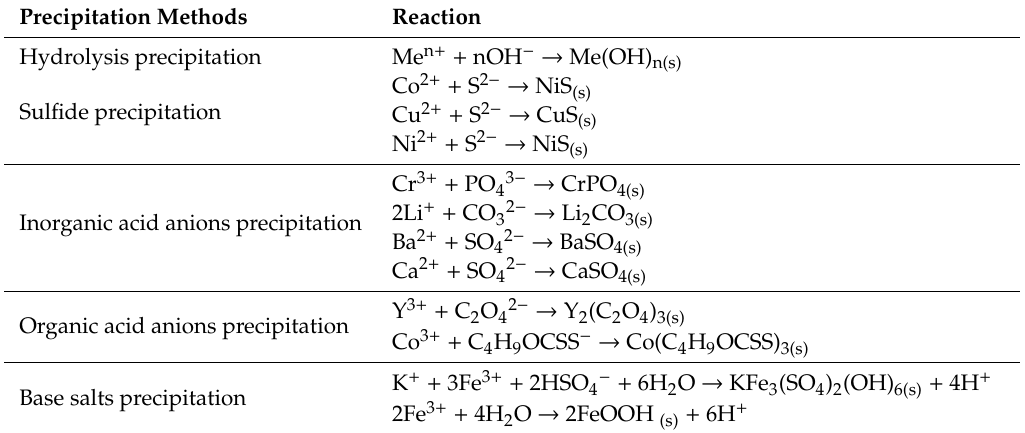
Table 2. Methods of precipitation based on chemical reactions